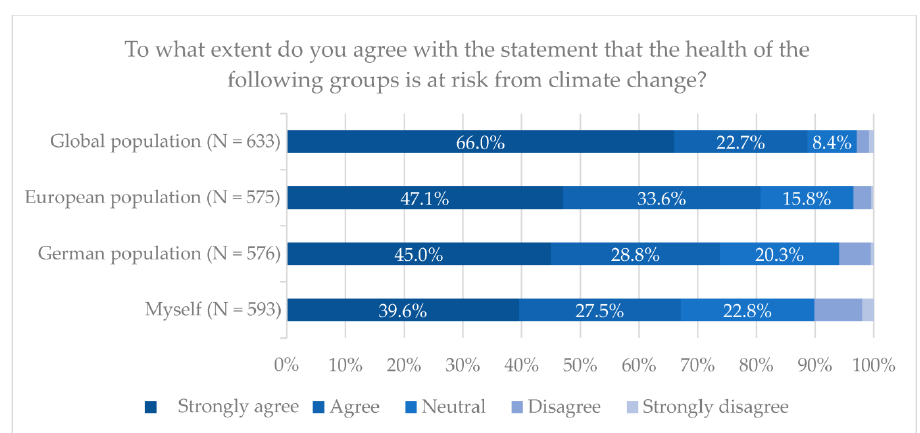
Figure 1. Health at risk from climate change, by population group. Participants believed that extreme weather events (87.8%), problems with the quality and supply of drinking water (74.2%), and rising sea levels (66.8%) were the three most relevant factors associated with climate change and its health risks. An additional 54 fac- tors were proposed as free text answers. Predominantly, these fell into the categories of hunger/food security (n = 13), flight/migration (n = 10) and war (n = 8). Furthermore, par- ticipants ranked accidents and deaths from extreme weather events (61.6%), infectious diseases (56.2%) and skin cancer (51.7) as the top three health risks connected to climate change. A significant proportion (n = 114; 18.2%) had experienced changes in their own health due to climate change (Table 3). Table 3. Suspected or perceived risks and health consequences associated with climate change. Variable Yes (%)